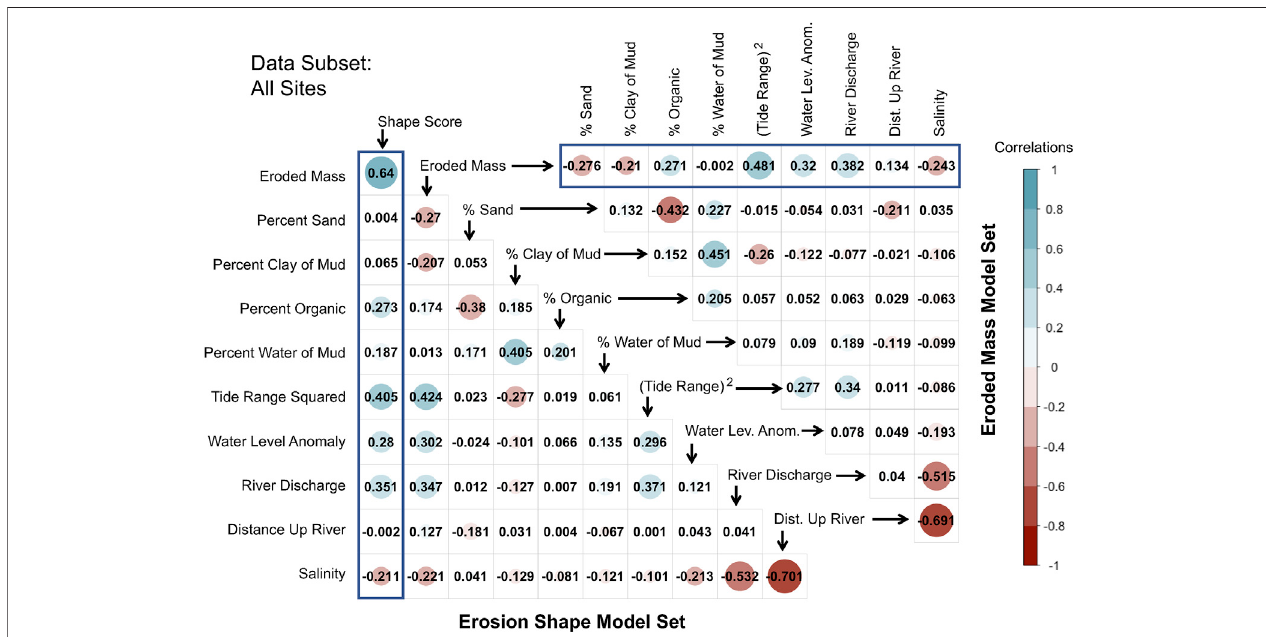
FIGURE 6 | Pearson correlation plot results for the All Sites data subset. Upper and lower diagonal plots show correlation values for the Eroded Mass and Erosion Shape model sets, respectively. Correlations with the response variables are boxed in blue.